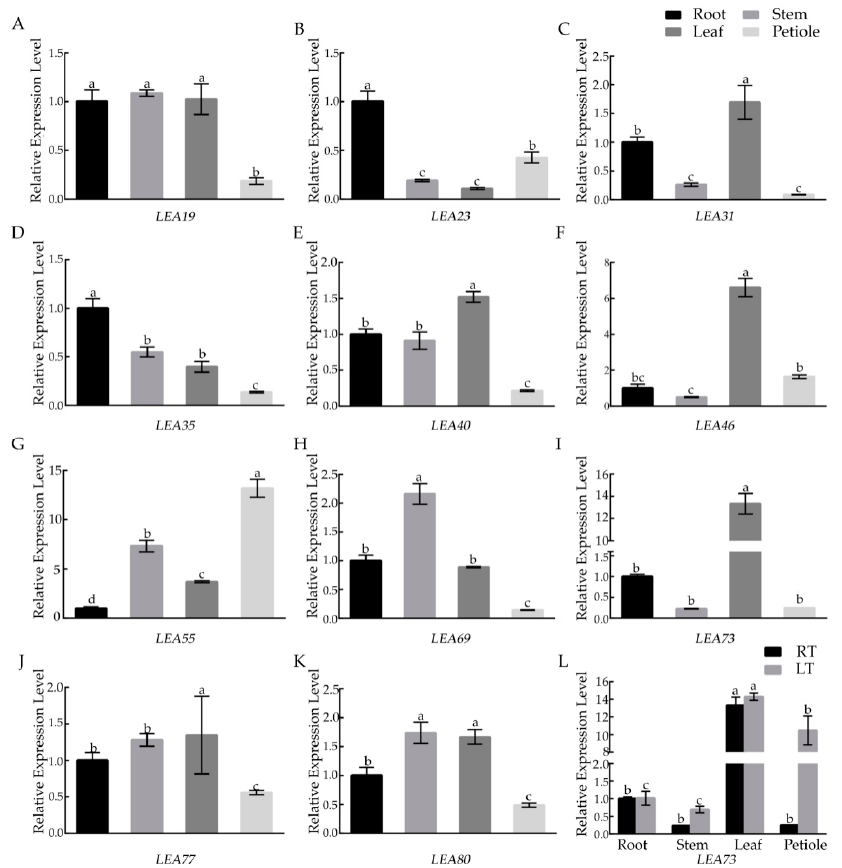
Figure 7. Expression of BcLEA genes in different tissues in Wucai. Figure ( A – K ) show the relative expression of BcLEAs in different organs in Wucai. The relative expression of BcLEA73 in the roots, stems, leaves, and petioles at regular temperature and low temperature is indicated in ( L ). Bars with different letters “a, b, c, d” above the columns indicate significant differences ( p < 0.05, Duncan’s range test) on a given day of treatment. Relative gene expression levels were calculated using the 2 − ∆∆ Ct method.